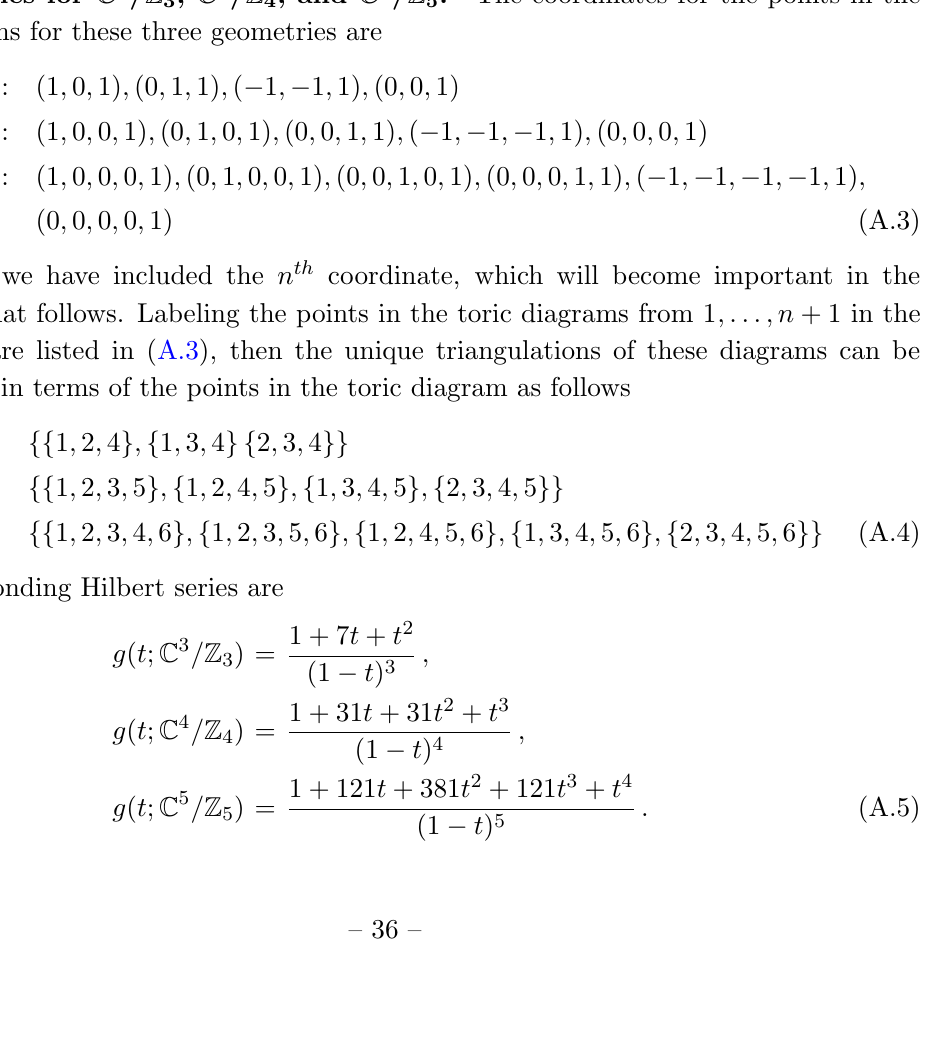
Figure 16 . The toric diagrams and dual web diagrams for C 3 = Z 3 and C 4 = Z 4 . Hilbert series for C 3 = Z , C 4 = Z , and C 5 = Z 3 4 5